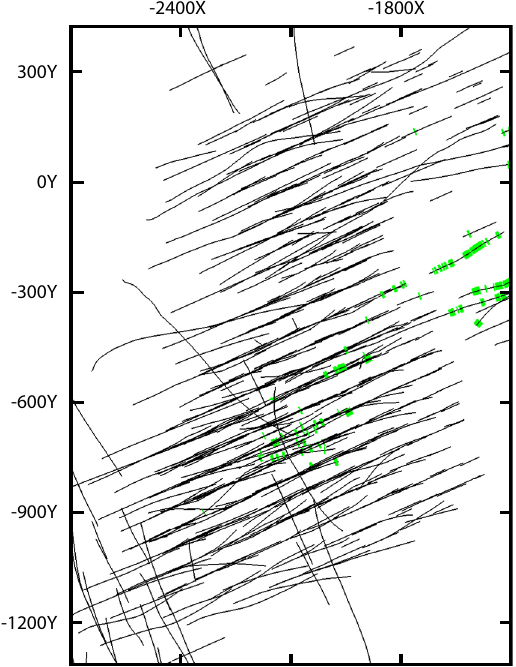
Figure 7. Borehole intervals with dolomite carbonatite (green) projected on horizontal plane. Black lines – boreholes. The map was generated by Micromine 2016, commercial license (http://www.micromine.com).